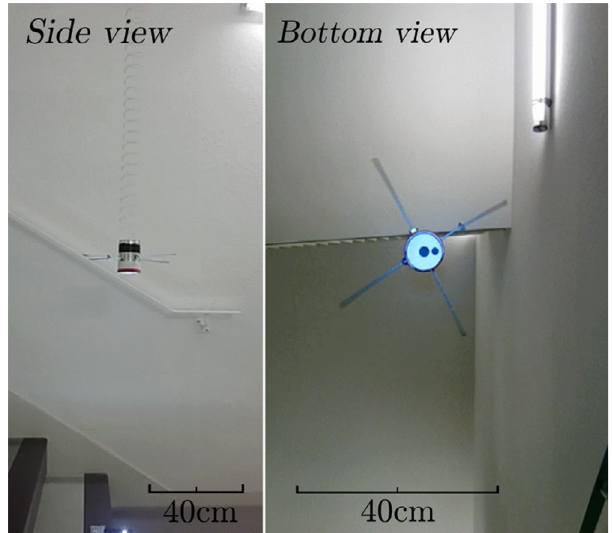
Fig. 3. Snapshots of the pendulum as captured by the two